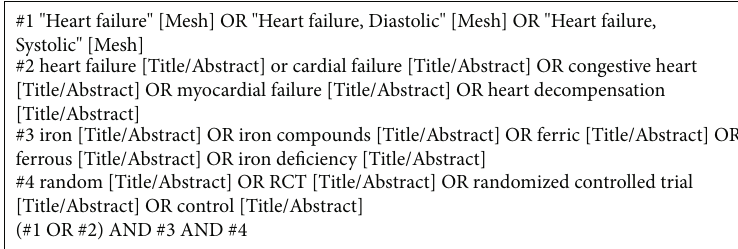
Figure 1: The search strategy of PubMed.